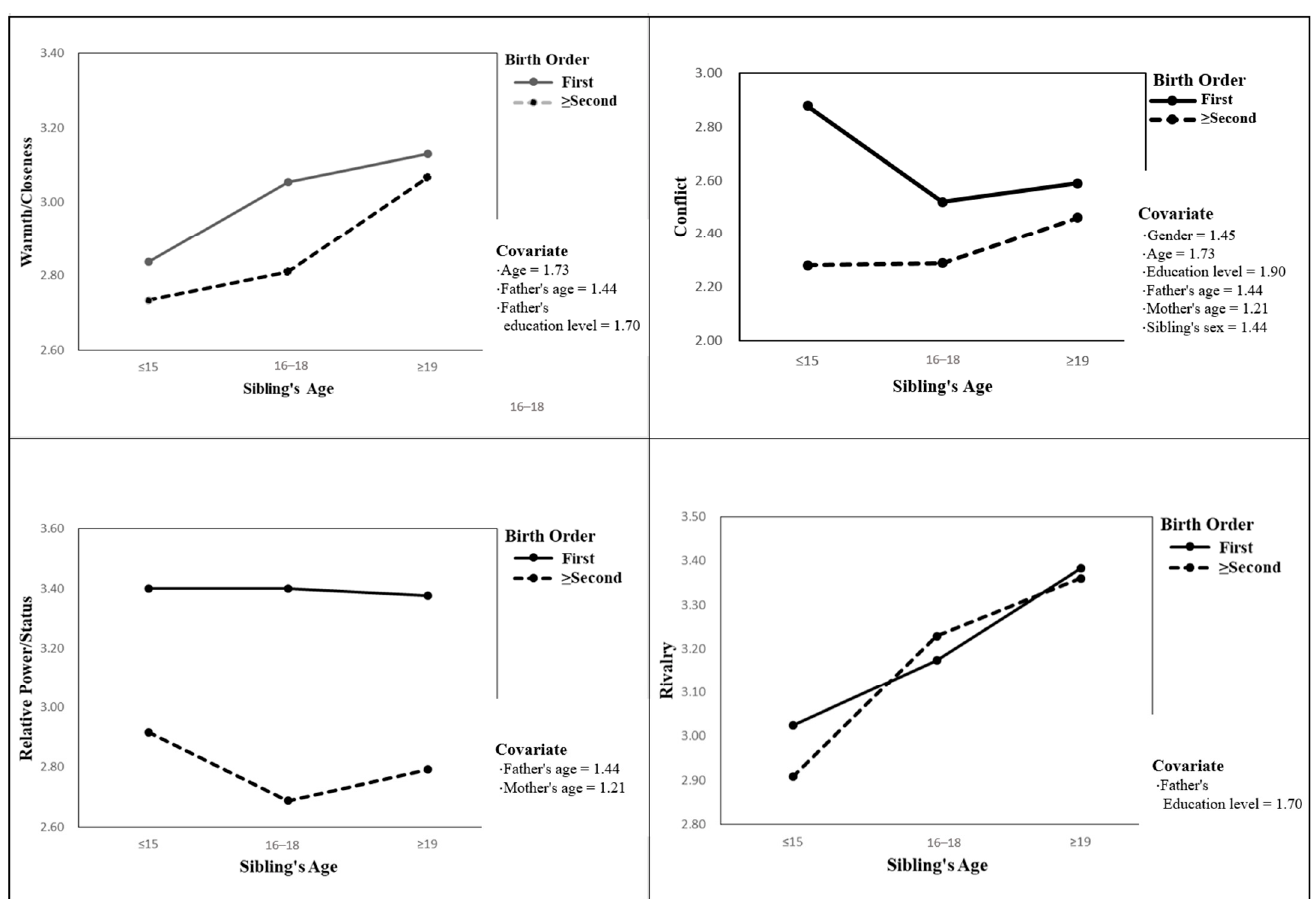
Figure 1. Factors of sibling relationships according to birth order and sibling’s age.